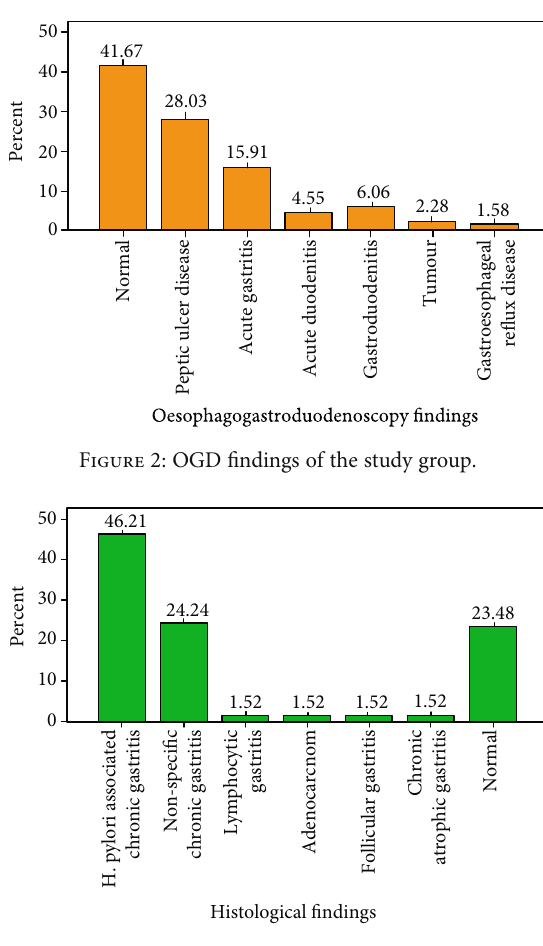
Figure 3: Histological fi ndings of the study group.